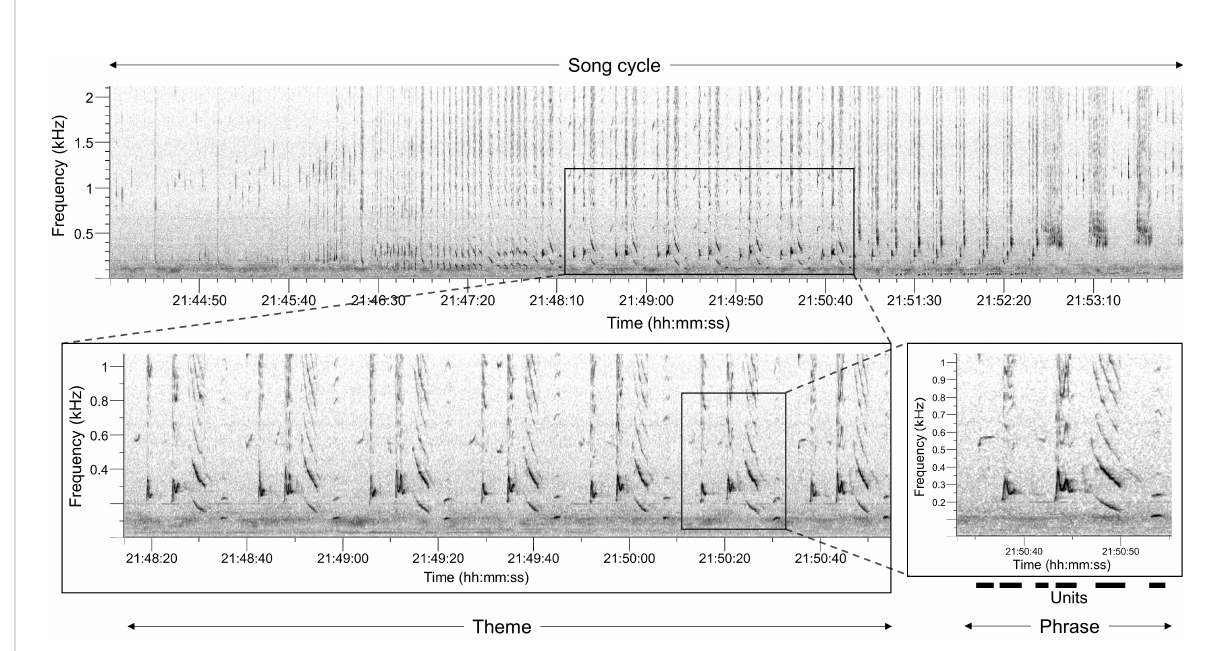
FIGURE 2 Spectrograms illustrating the humpback whale song and its hierarchically structured elements (units, phrase, theme, song cycle), recorded by LoVe Ocean Observatory in March 2018. The spectrograms were produced using fast Fourier transform (FFT) size 8092 Hann-window with a frequency resolution of 5.69 Hz and a 70% overlap. The illustrated full song cycle consists of several themes. The theme example of the song cycle is composed of several phrase repeats. One phrase is composed of a repeating pattern of individual